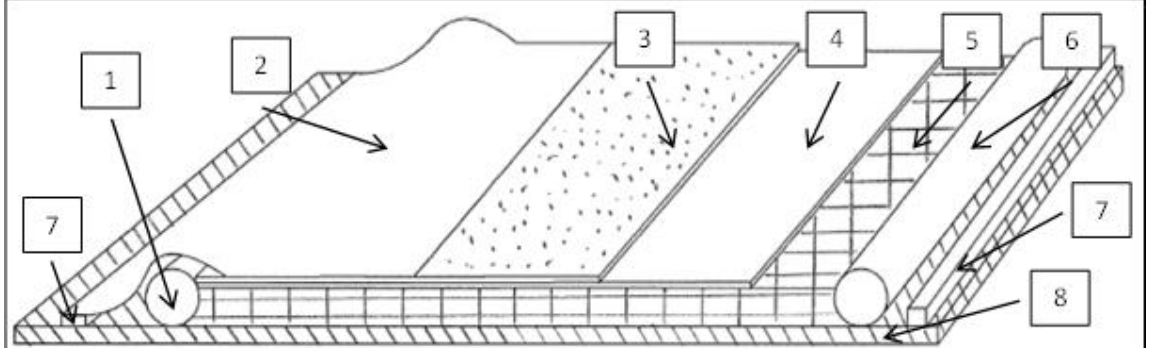
Figure 1. Schematic drawing of a typical vacuum infusion construction; mold assembly: 1, inlet; 2, vacuum bag; 3, distribution medium; 4, peel ply; 5, reinforcement; 6, outlet; 7, vacuum seal; 8, mold die; referring to Correia N.C. et al . (2005)